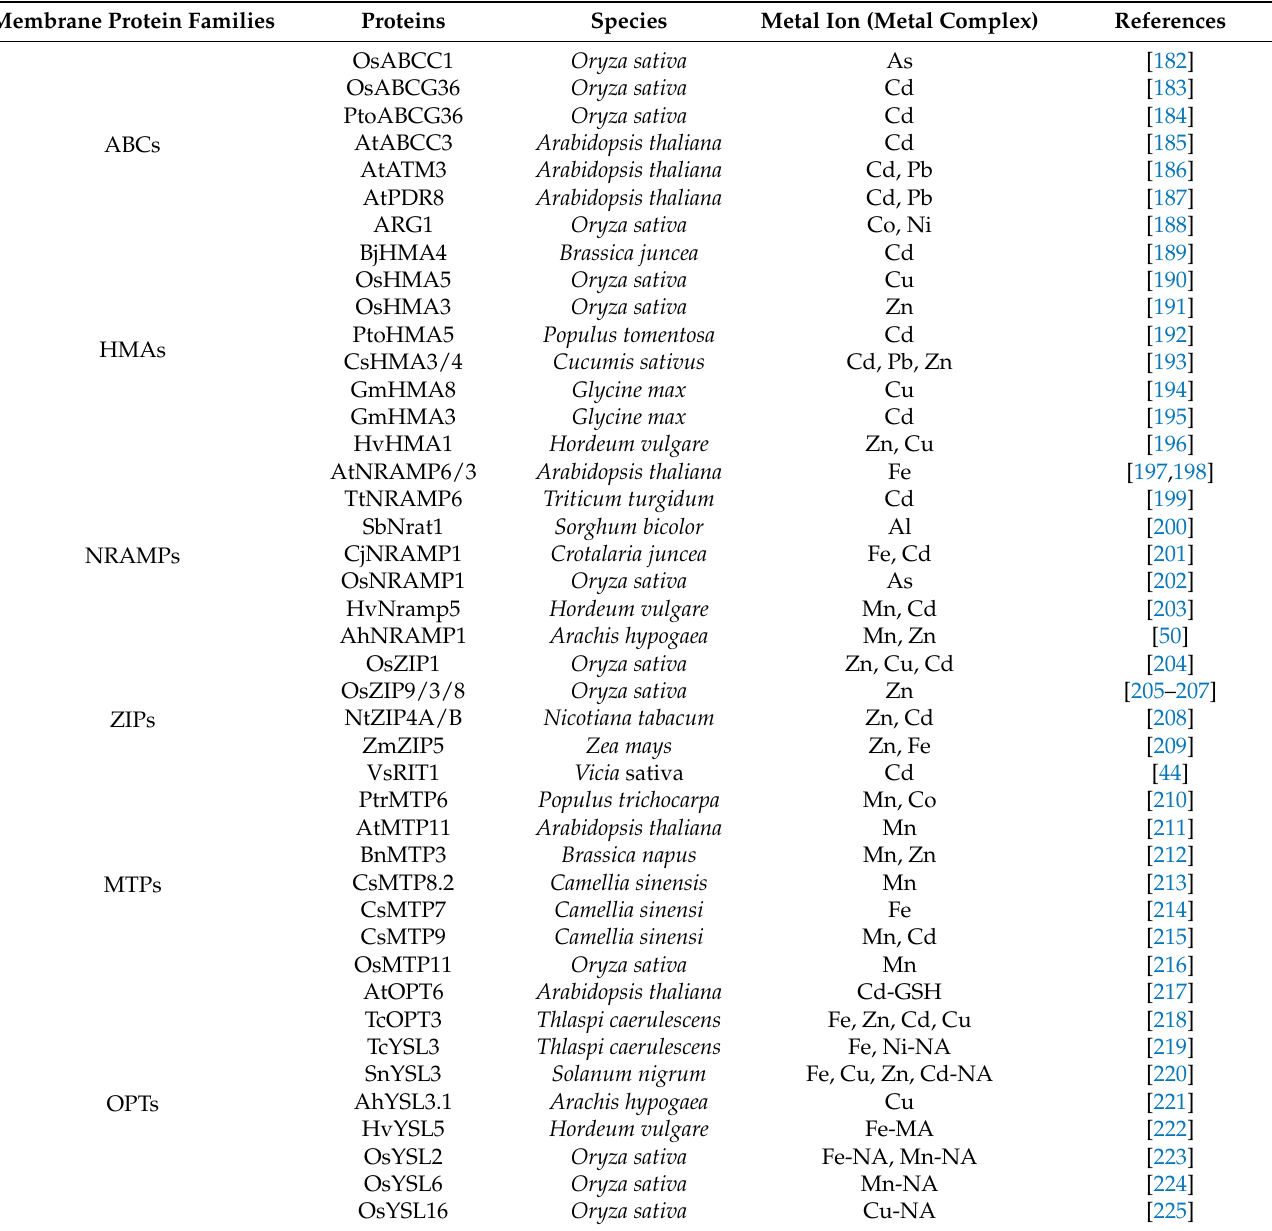
Table 1. Different members of the membrane protein family in different species bind specifically to metal ions (or complexes). Membrane Protein